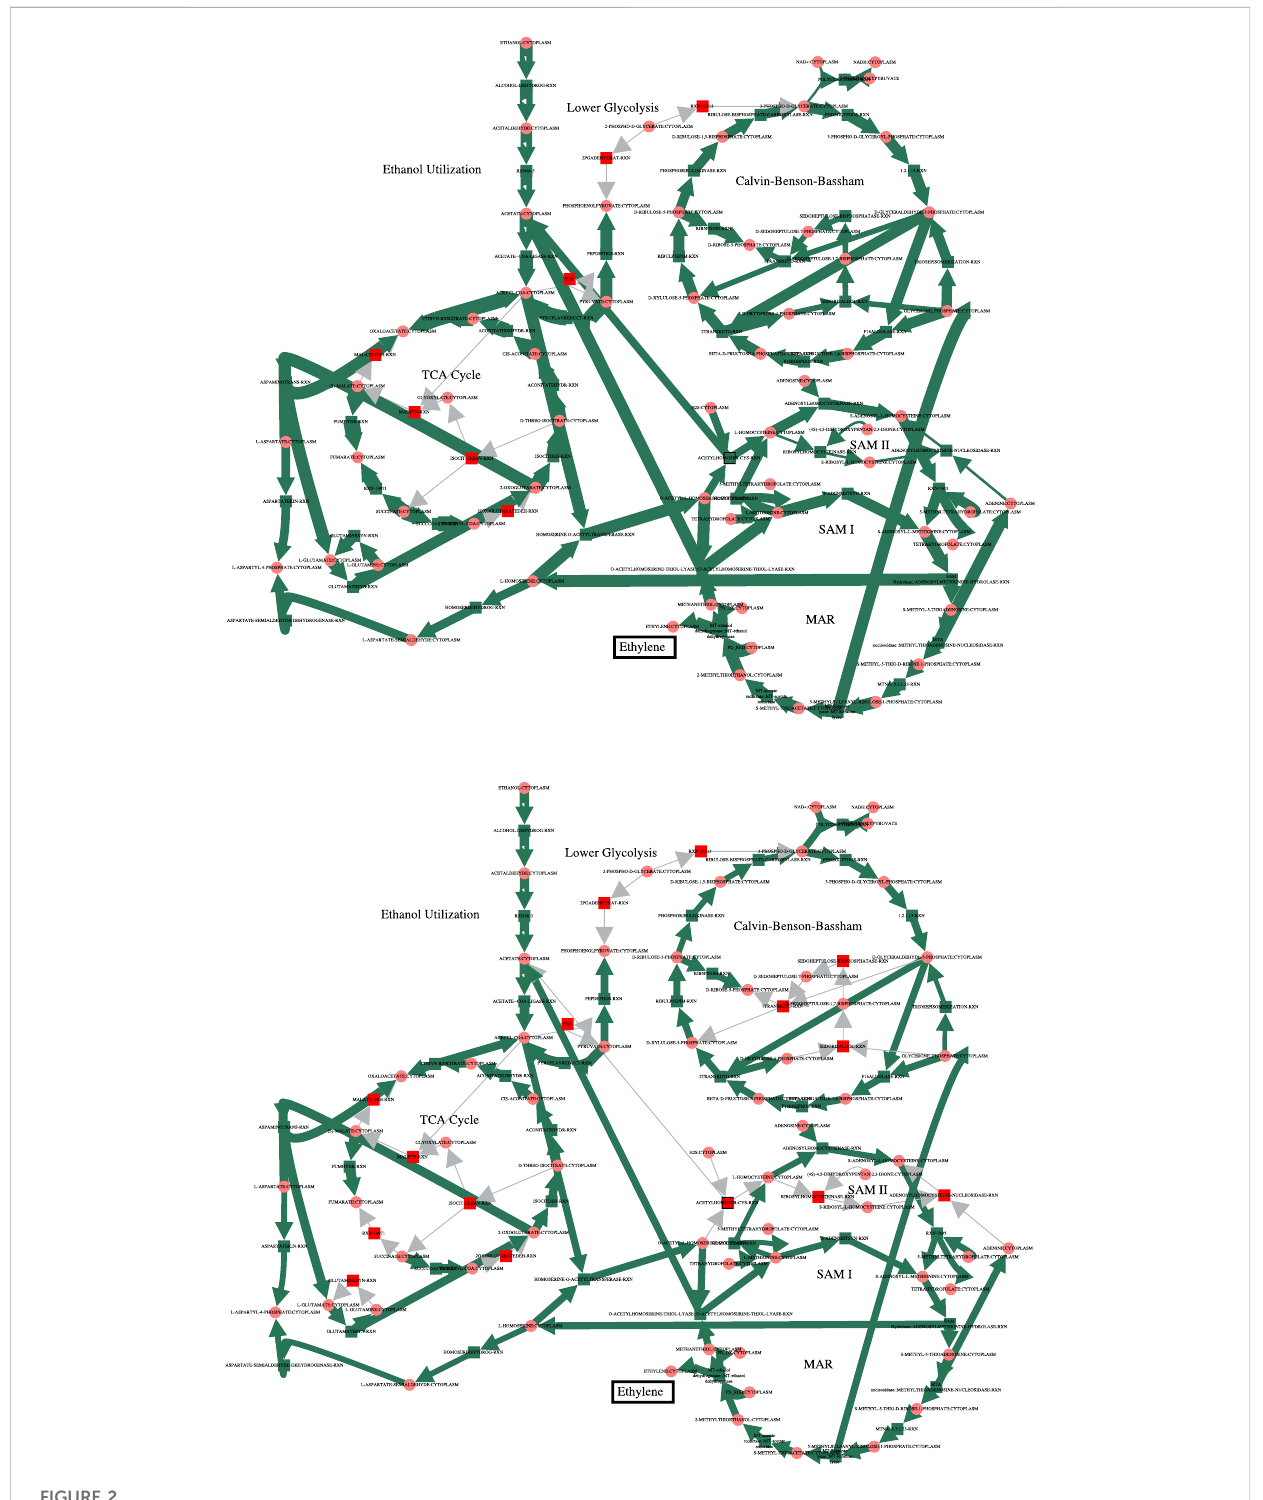
FIGURE 2 Comparison ofthe fl uxes through central metabolism for the MCAmodel (top) and thePCO model (bottom). Flux through thegrowth reactionsare maximized by turning reaction fl uxes down but not off. The decreased fl ux through central metabolism in the PCO model re fl ects the same decrease shown below the red line for the MCA model in Figure